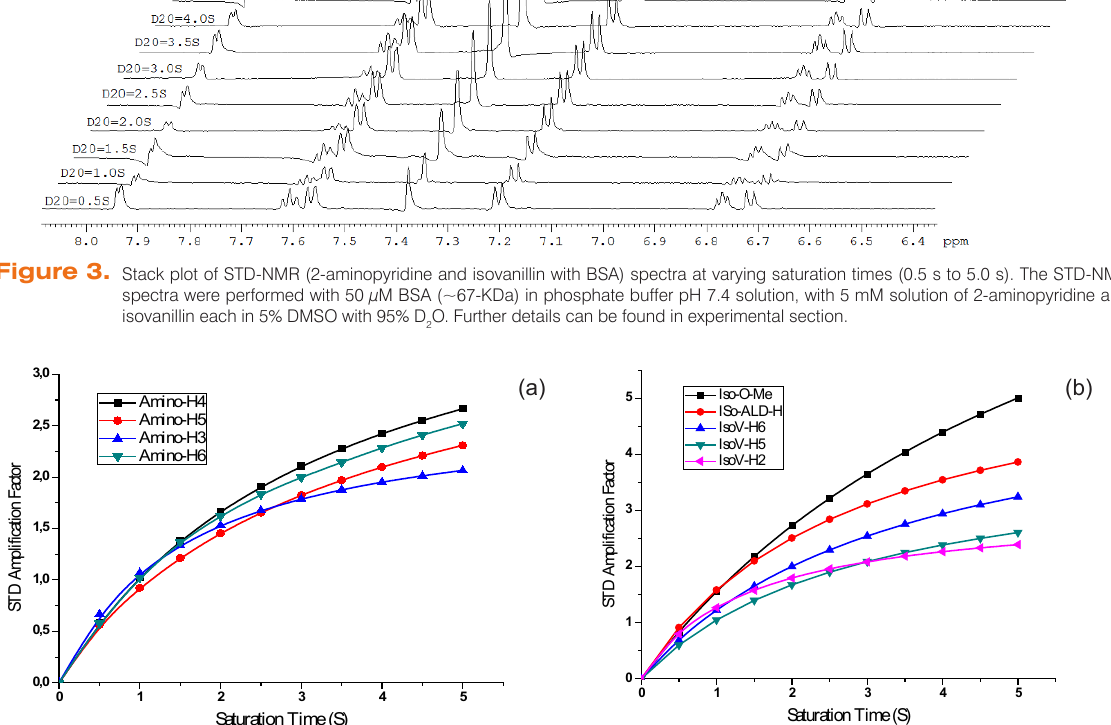
Figure 4. STD ampli fication factors plot of 2-aminopyridine (A) and Isovanillin (B) as a function of saturation time, as a result of integral values obtained from different STD spectra (shown in Fig. 3 ). Methoxyl signal with largest intensity of Isovanillin was given the 100% STD effect and rest signals were normalised with rfrence to this